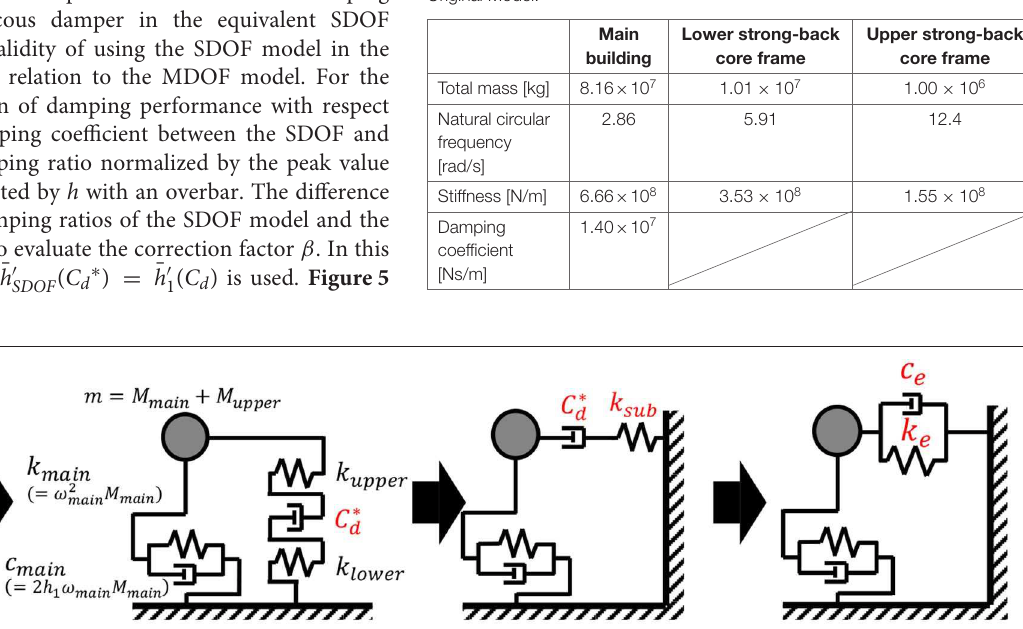
TABLE 1 | Parameters of equivalent SDOF models of three subassemblages for Original Model.